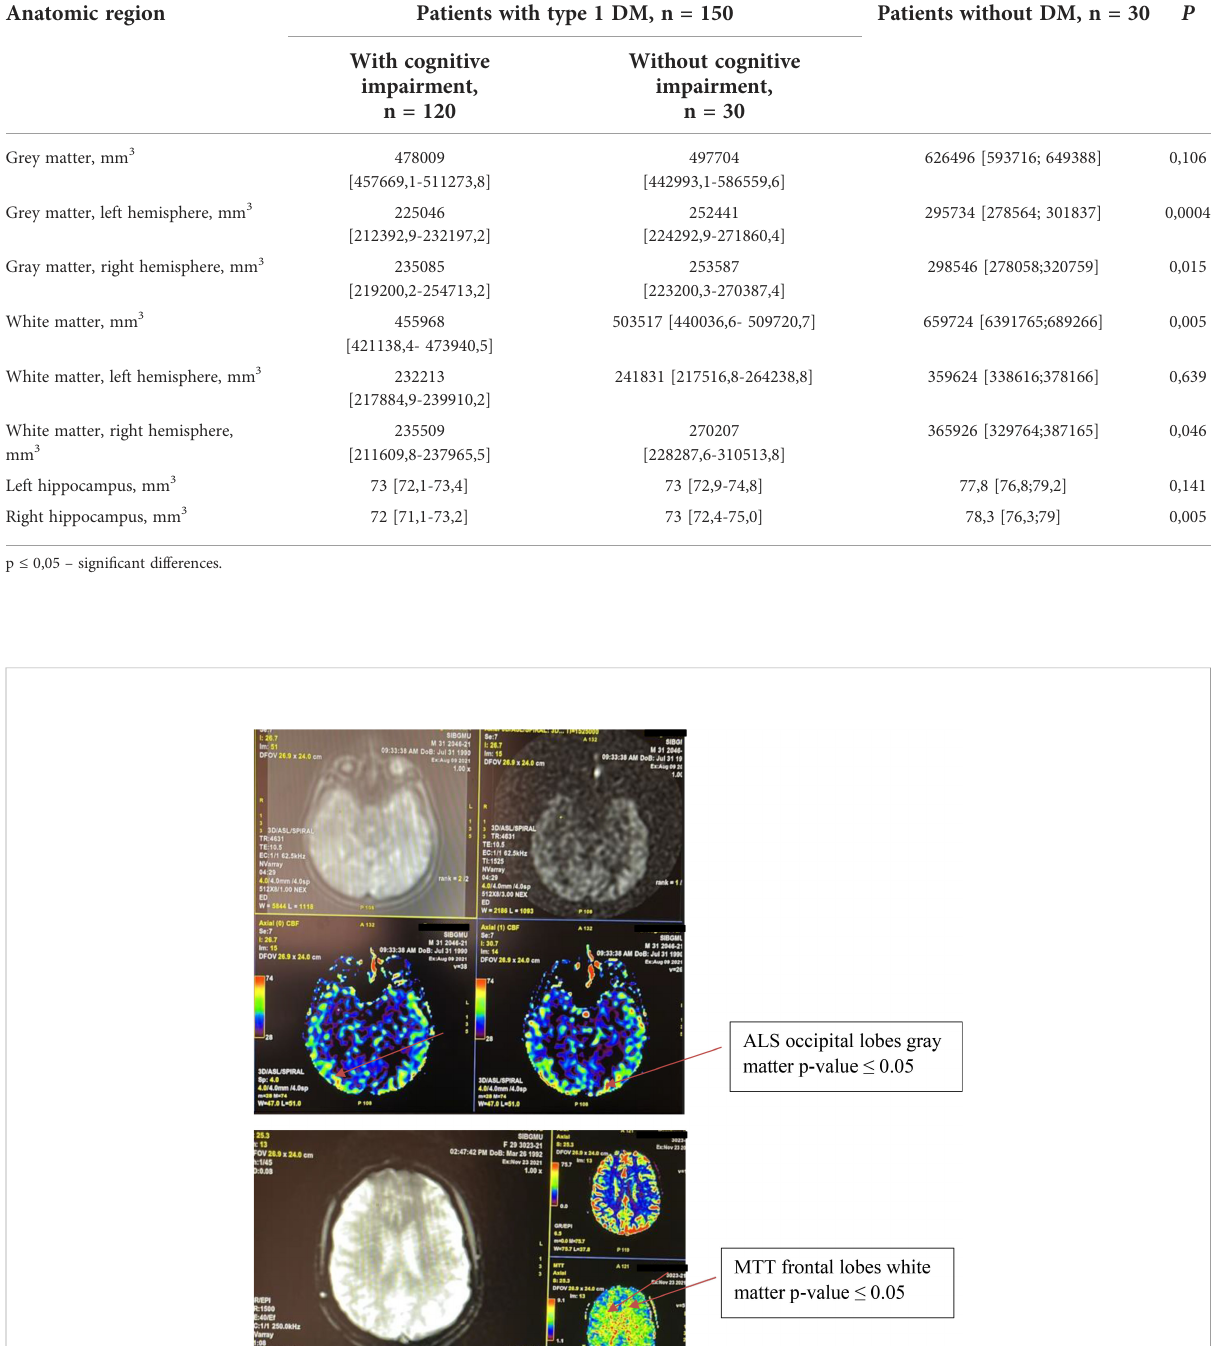
TABLE 3 Brain segmentation in patients with type 1